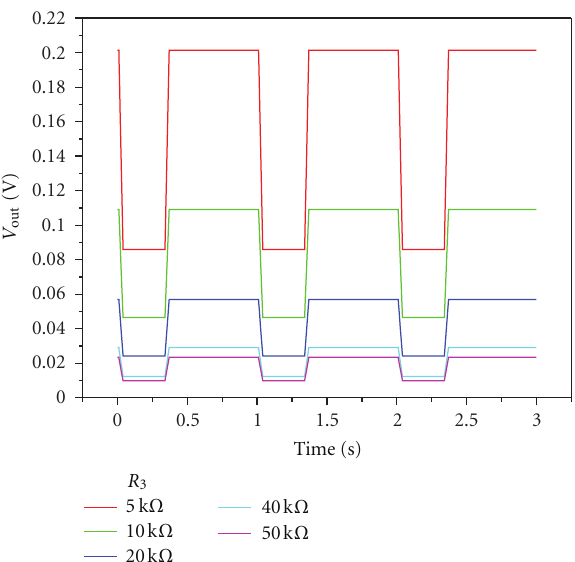
Figure 16: Output voltage levels for the pulse parameter for a change of the resistance of R 3 (5 (K Ω ) ∼ 50 (K Ω